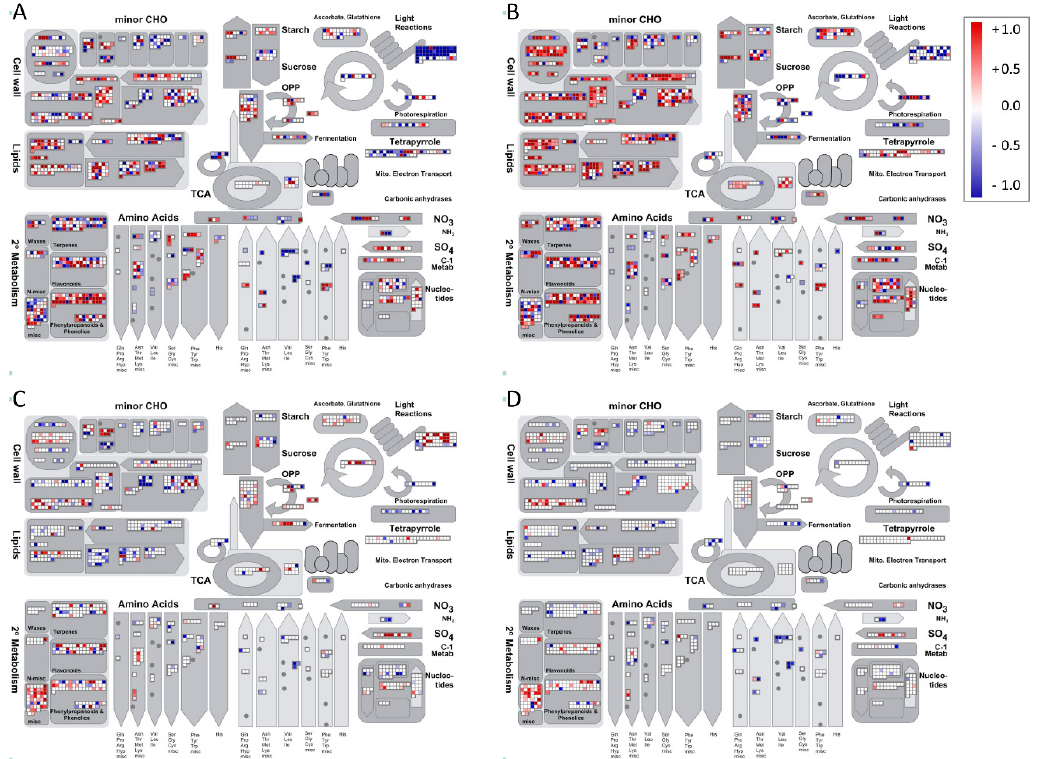
Figure 4. Metabolic overviews referred to four comparisons: T vs. C (panel A ), TT vs. CC (panel B ), TTC vs. CCC (panel C ), TTCC vs. CCCC (panel D ). The color scale red-blue illustrates Log 2 FC values, the red color refers to upregulated transcripts, the blue color refers to downregulated ones ( N = 3, q -value < 0.05).